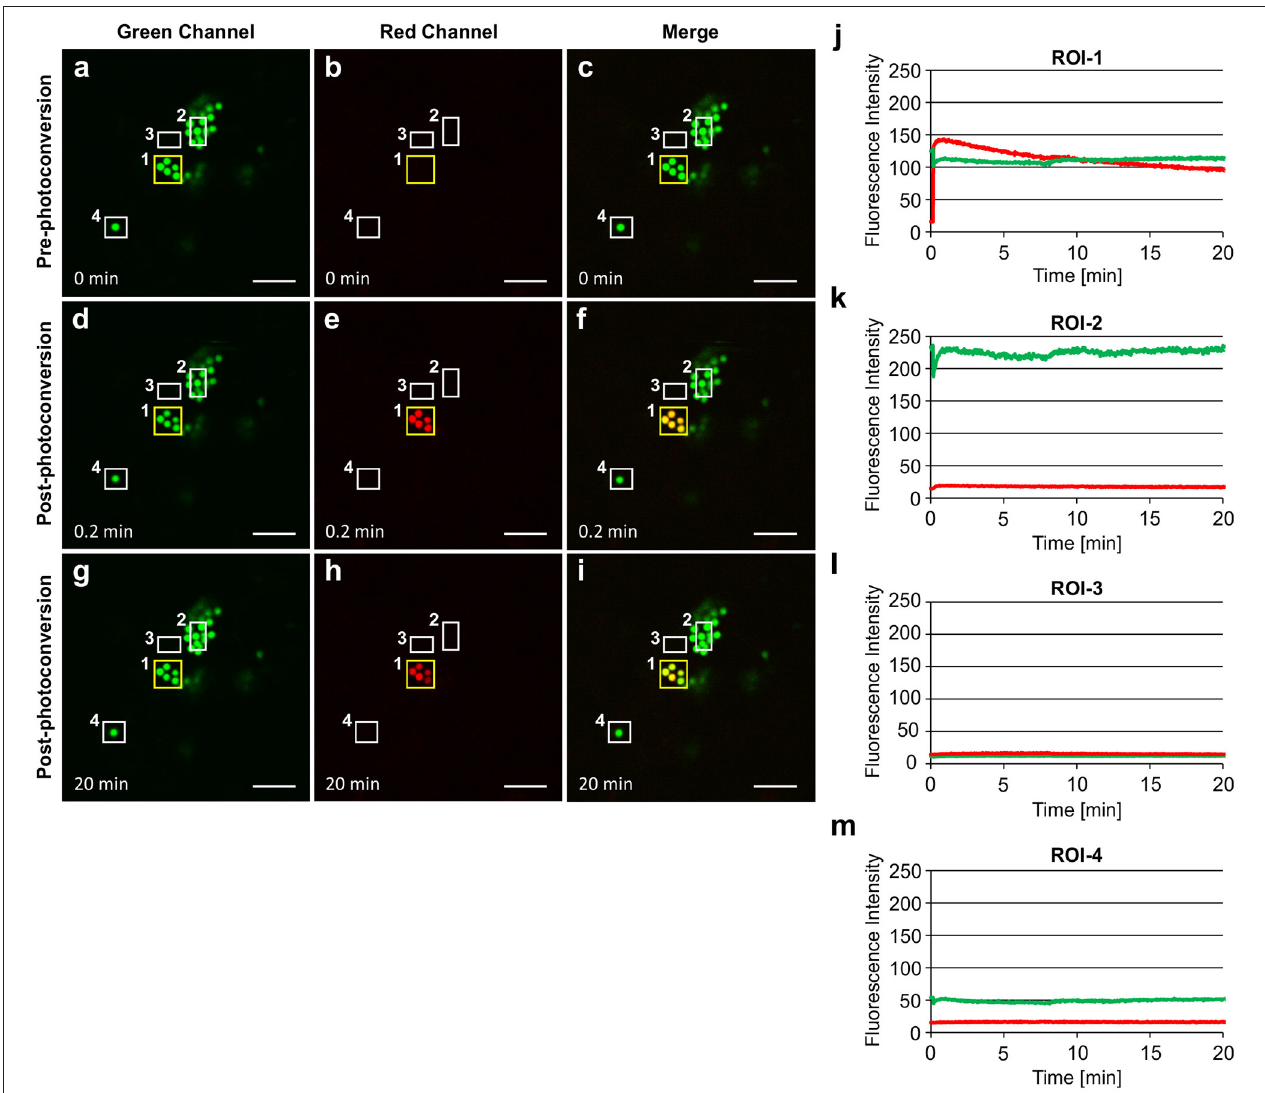
FIGURE 8 | Zera PB contents are not as soluble as ELP or HFBI PBs. The yellow box highlights the region of irradiation (ROI-1). Other regions of interests are shown in white boxes (ROI-2-4). (A–C) Zera PBs can be seen only in the green channel before photoconversion. (D–F) PBs in ROI-1 were irradiated once and turned red within seconds. (G–I) The majority of photoconverted red signal remains in the irradiated PBs. (J–M) Changes in the fluorescence intensity of the green and red signal in ROI-1 (J) , ROI-2 (K) , ROI-3 (L) , and ROI-4 (M) . Imaging was done in the presence of Latrunculin-B to keep PBs in the same focal plane. Notches indicate the irradiation period. All images were acquired at 4-dpi in sequential mode. Bar, 10 µ